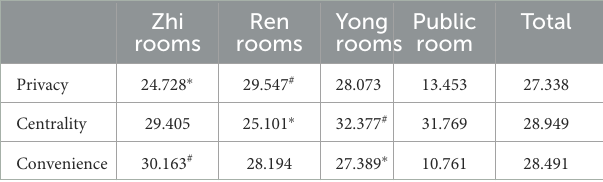
TABLE 4 Statistics of overall spatial